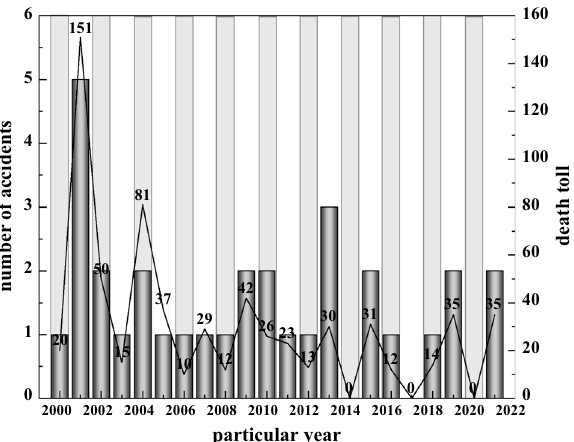
Figure 1. Statistics of major accidents in non-coal underground mines over the years.